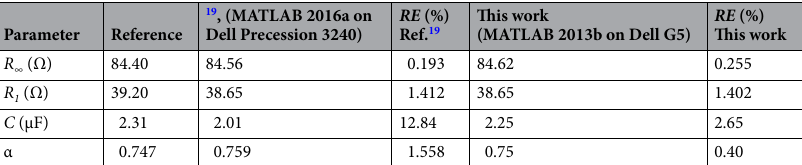
Table 2. Performance comparison of our estimation method and CNLS method 19 .